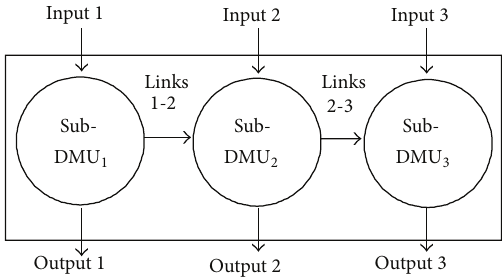
Figure 2: The structure of network DEA with chain links and nonassignable